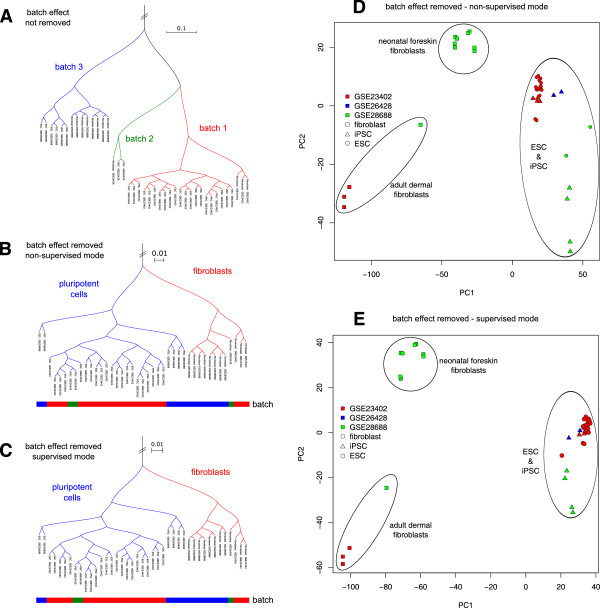
Hierarchical clusterings and principle component analyses of ExpressionSets outputted by virtualArray. On the basis of the combined dataset from three different platforms a hierarchical clustering was calculated based on Euclidian distance matrices. Samples from GSE23402 are marked in red, samples from GSE26428 are marked in green and samples from GSE28688 are marked in blue. ESC, human embryonic stem cells; iPSC, human induced pluripotent stem cells. A, clustering of combined data without batch effect removed, B, clustering of combined data with batch effect removed in non-supervised mode; C, clustering of combined data with batch effect removed in supervised mode. The direct analysis of the combined dataset exhibits strong batch effects (A), that can be reduced by the use of EBM (B) in non-supervised mode. The benefit of the supervised mode can be seen in PCA plots (D, E) but not hierarchical clusterings (C). Principle component analyses were performed on the combined batch effect removed dataset. The batch effects were removed in non-supervised (D) and supervised mode (E), respectively.